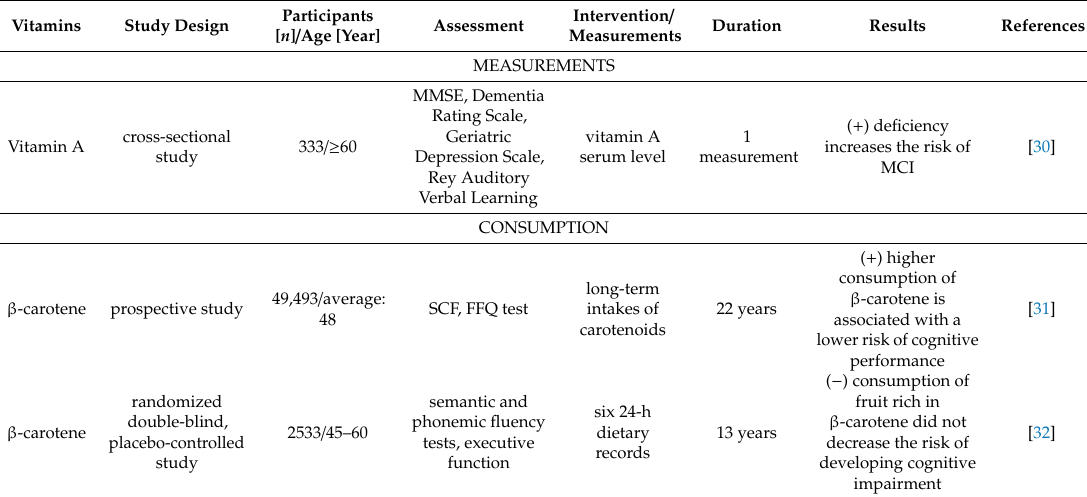
Table 3. Summary of studies on vitamin A intake and